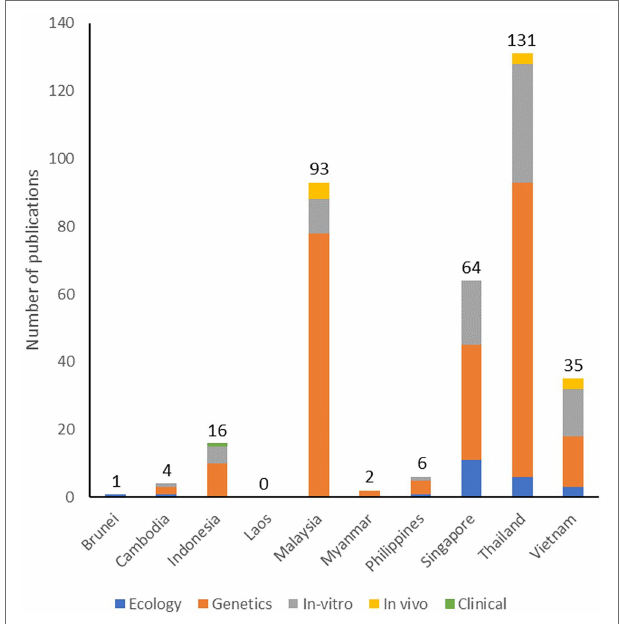
FIGURE 1 | Number and types of original research articles on phages published in SEA and indexed in PubMed from 2011 to